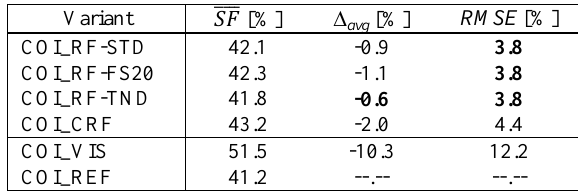
Table 5 . Results of coefficient of imperviousness computed in different variants. All values are computed based on the 23 subbasins. Best results are print in bold